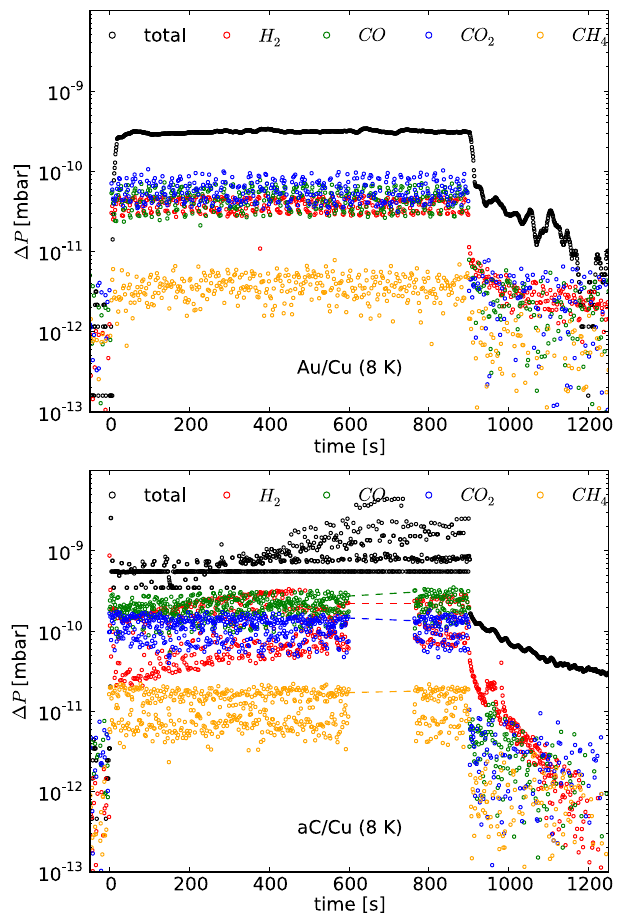
FIG. 7. Heavy-ion-induced pressure rises at 8 K target tem- perature. Partial pressure rises ( (cid:2) P ) of H 2 , CO, CO 2 , CH 4 , and total pressure rises measured for the Au = Cu and aC = Cu samples continuously bombarded under (cid:2) ¼ 0 (cid:2) with 1 : 4 MeV = u Xe 18 þ ions are shown.